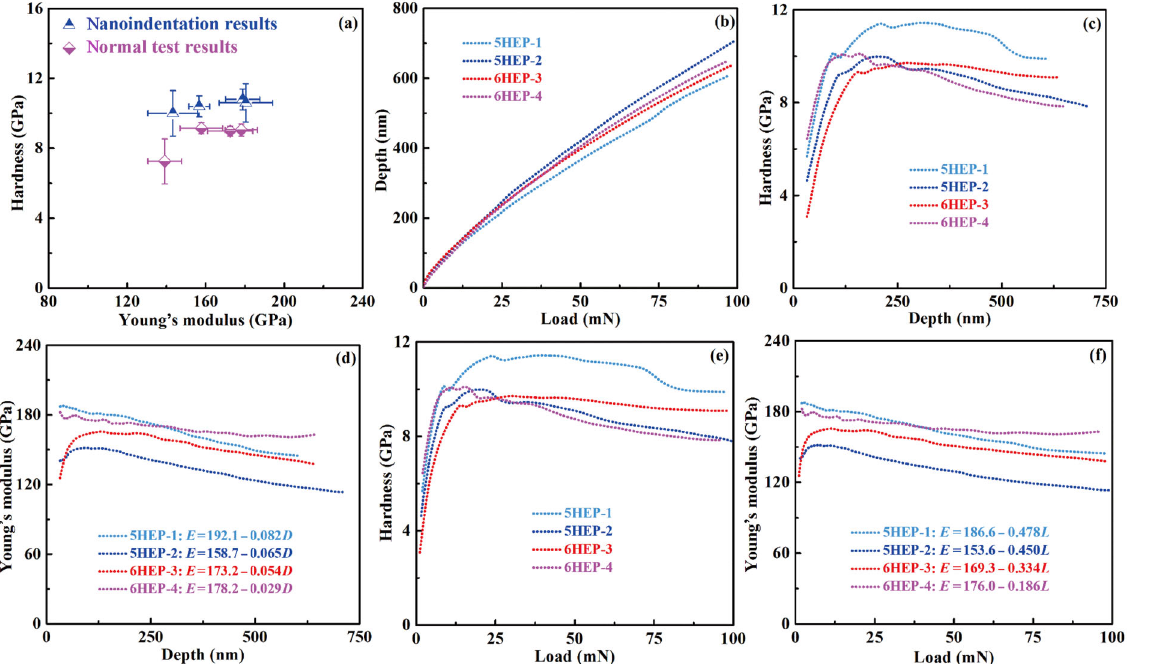
Fig. 5 Mechanical properties of (La 1/5 Pr 1/5 Dy 1/5 Ho 1/5 Tm 1/5 )Ta 3 O 9 (5HEP-1), (Gd 1/5 Dy 1/5 Ho 1/5 Er 1/5 Tm 1/5 )Ta 3 O 9 (5HEP-2), (La 1/6 Sm 1/6 Eu 1/6 Dy 1/6 Ho 1/6 Tm 1/6 )Ta 3 O 9 (6HEP-3), and (Eu 1/6 Gd 1/6 Dy 1/6 Ho 1/6 Er 1/6 Tm 1/6 )Ta 3 O 9 (6HEP-4) ceramics: (a) nano-Young’s modulus and hardness measured by different methods, (b–f) variations in different parameters observed during nanoindentation advanced dynamic E and H